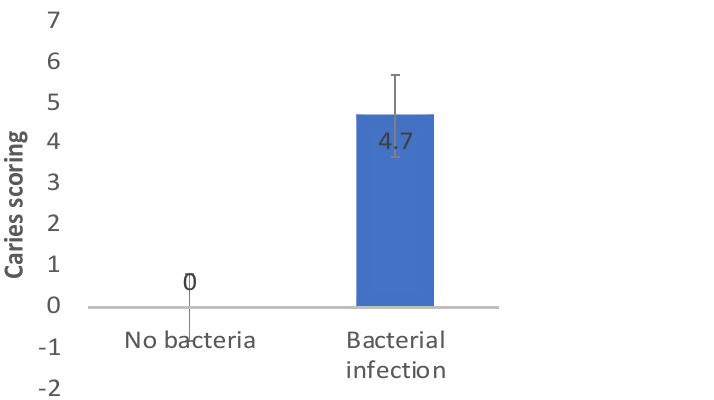
Figure 6. Caries scoring over hemi-sectioned molars after 5 days in caries-promoting conditions. Caries score increased significantly ( p = 0.011) in the bacterial-infected jaws (n = 5) compared to the no bacteria jaws (n = 5).